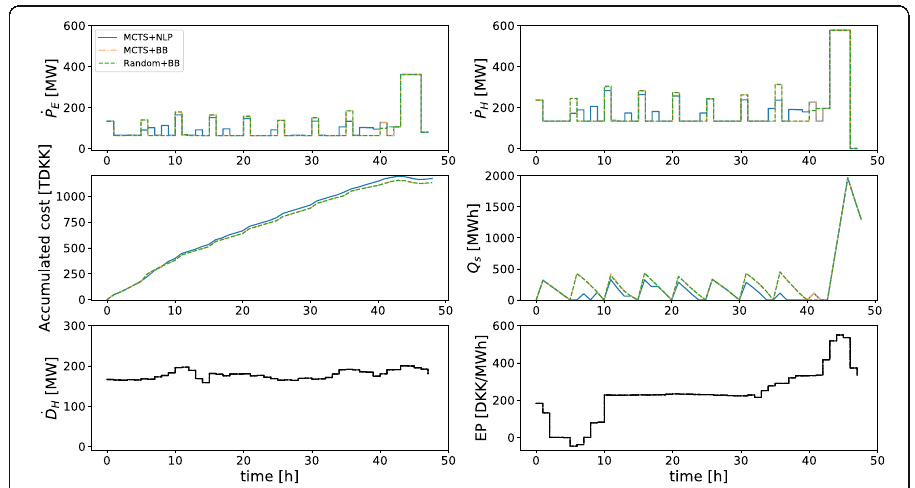
Fig. 8 Best scheduling for each method. The MCTS+NLP solution was found with W L = 13 and a cost of 1120 TDKK. The MCTS+BB solution was found with W L = 12 and a cost of 1098 TDKK. The Random+BB solution was found with W L = 14 and a cost of 1099